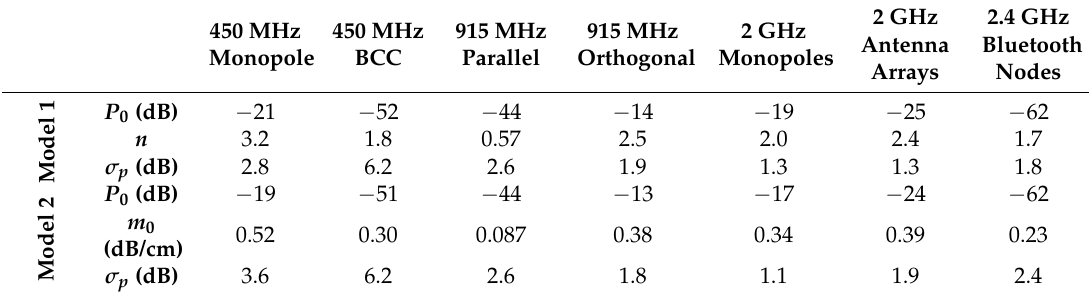
Table 2. Parameters of the path loss model shown in Equations (1) and (2) for all studied technologies. 450 MHz Monopole